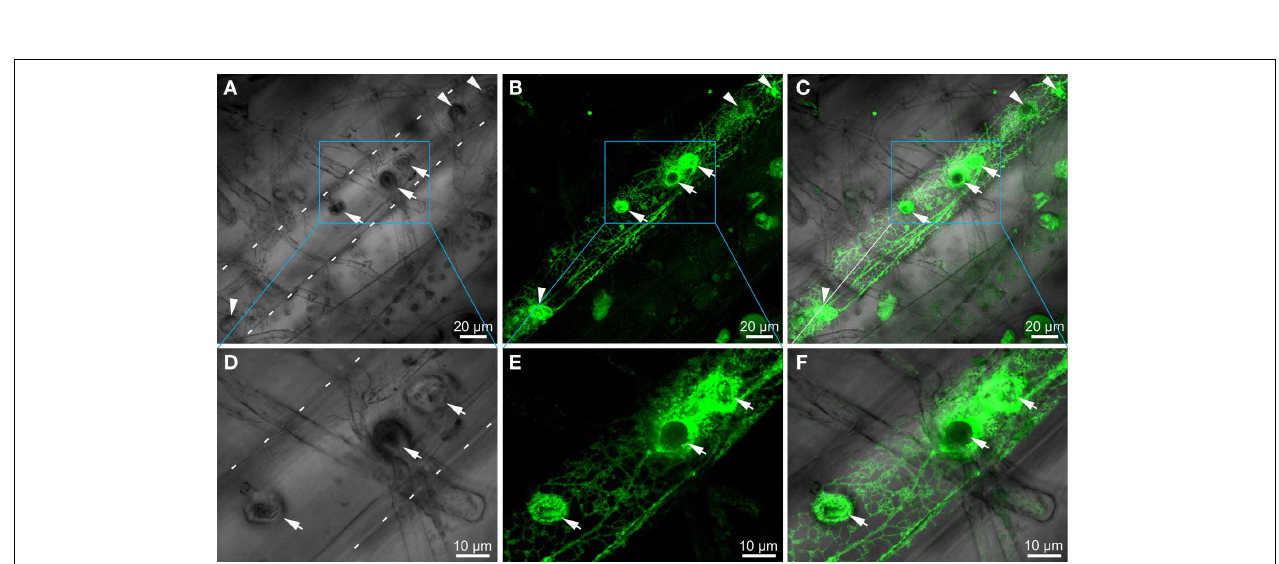
(SAIL_158_B06 and SAIL_158_B06 transformed with the non-functional construct P CEP1 ::pre-pro-3xHA-EGFP-KDEL). atcep1 , SAIL_158_B06; fct, atcep1 plants transformed with the functional reporter pre-pro-3xHA-EGFP-AtCEP1-KDEL; n-fct, atcep1 plants transformed with the non-functional reporter pre-pro-3xHA-EGFP-KDEL.